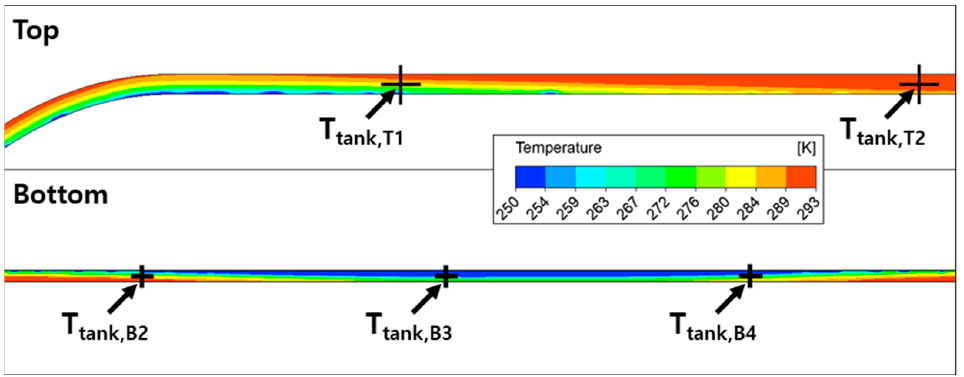
Figure 16. Distributions of the temperature at the top and bottom of the